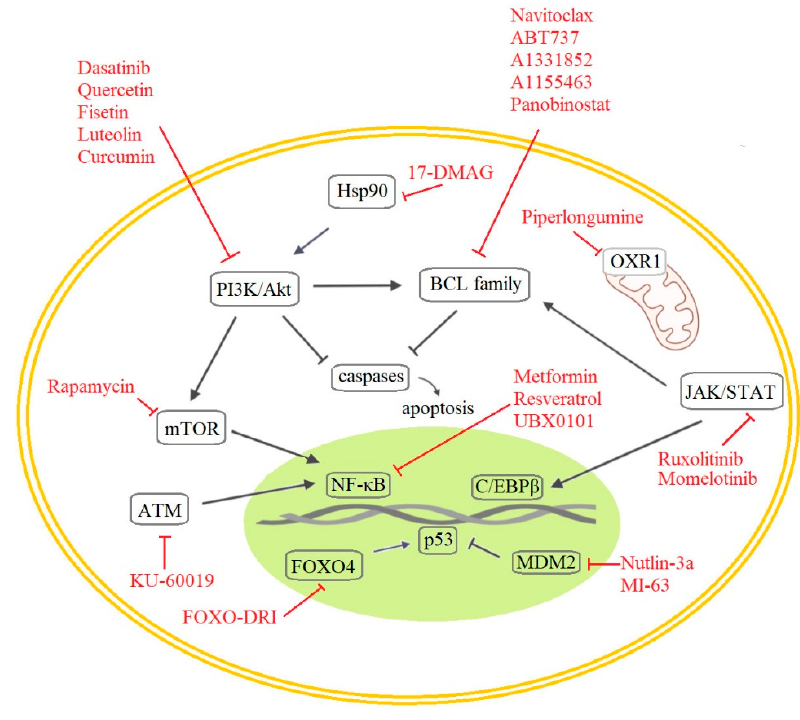
Figure 4. Molecular targets of senolytic